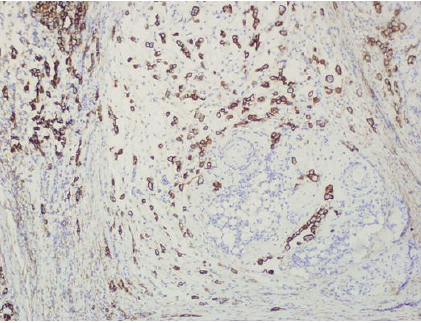
Figure 5: Immunohistochemistry showing D240-positive